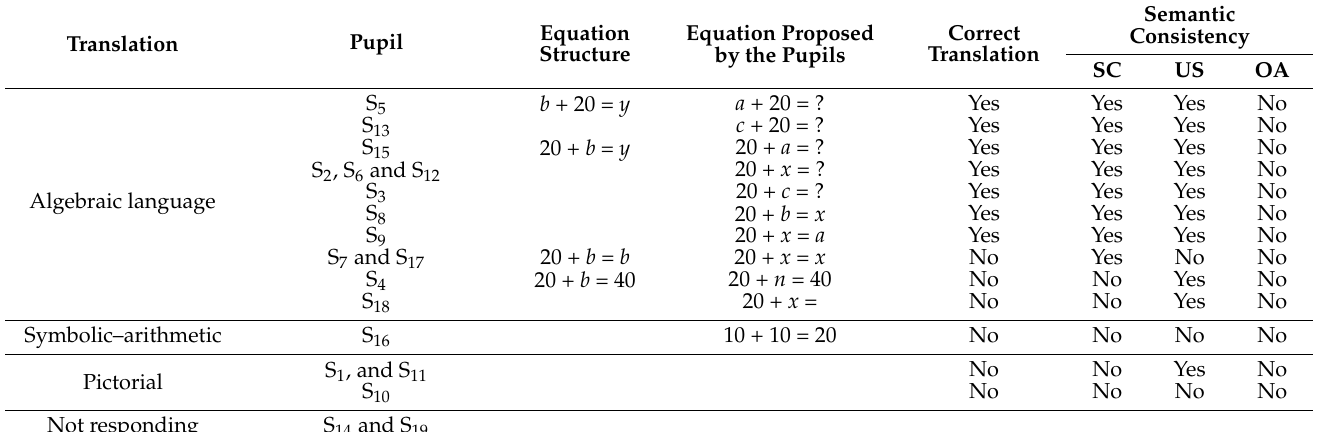
Table 2. Equations proposed by the pupils in the apple problem (structure y = 20 + b